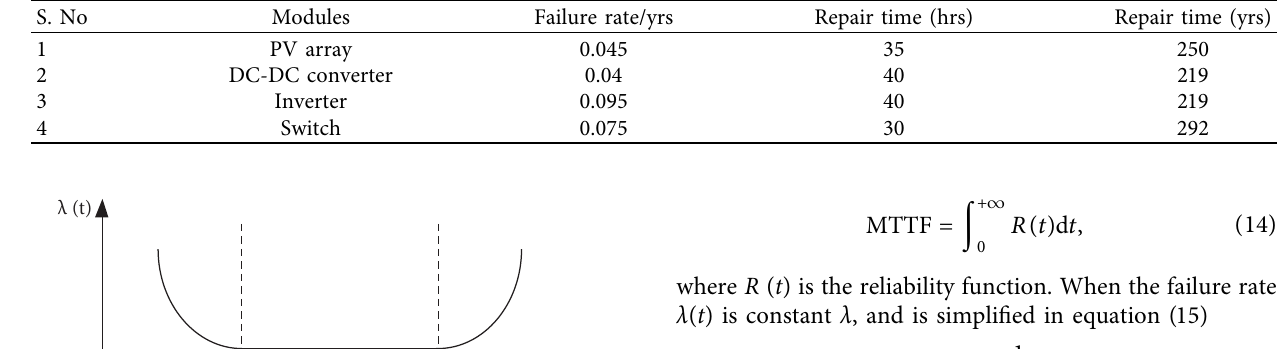
Figure 27: Failure rate